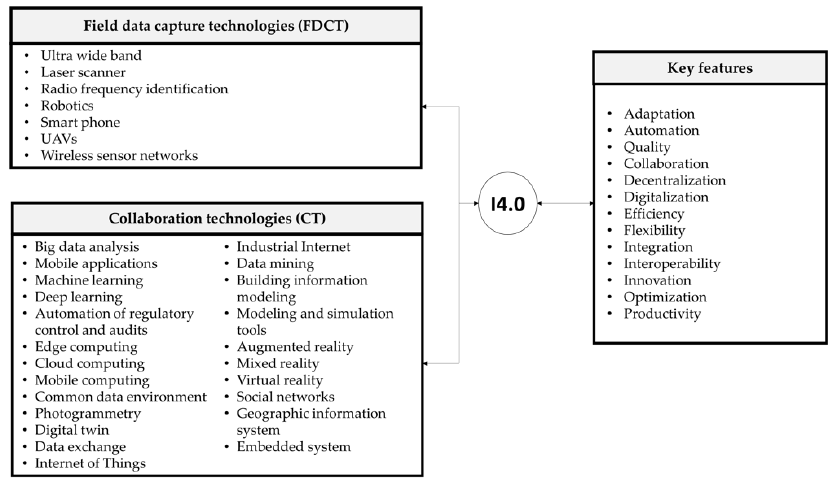
Figure 4. Key technologies and features of Industry 4.0. Adapted from [8].